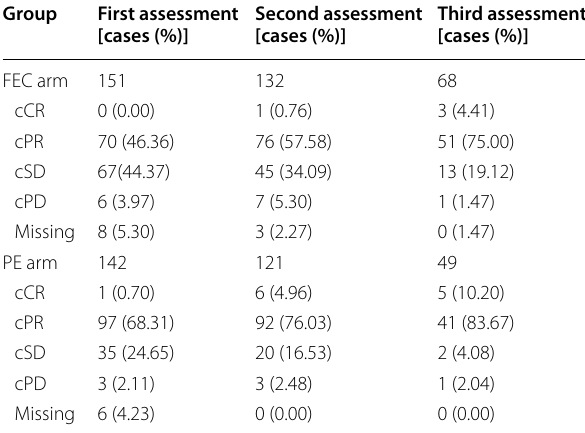
FEC tri-weekly 5-fluorouracil–epirubicin–cyclophosphamide regimen, PE weekly paclitaxel–epirubicin regimen, cCR clinical complete response, cPR clinical partial response, cSD clinical stable disease, cPD clinical progressive disease